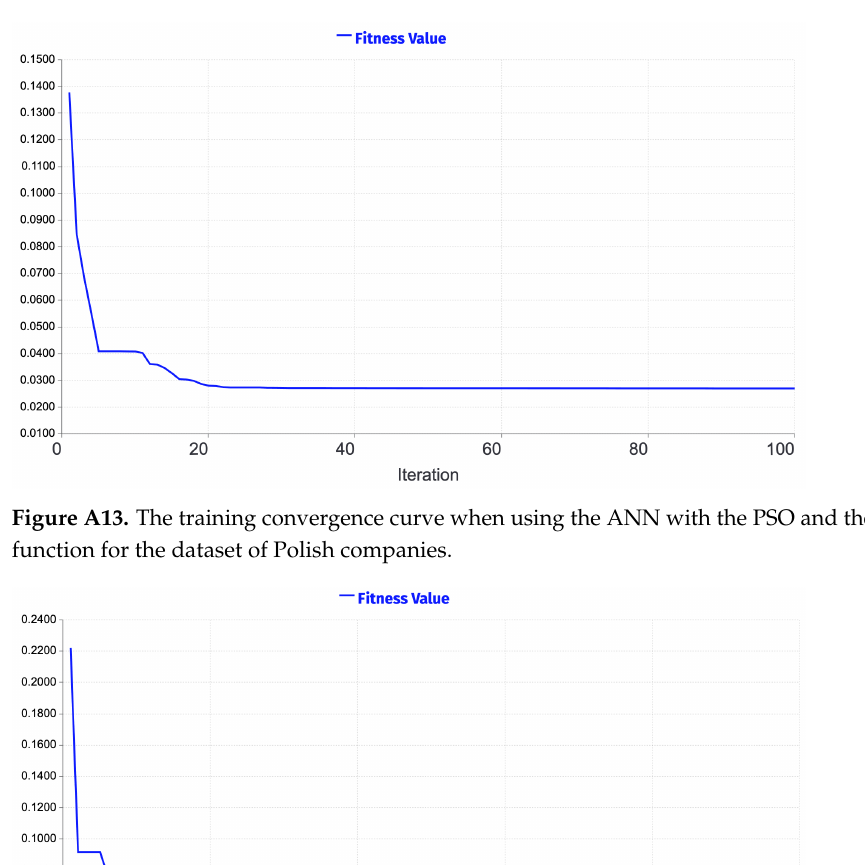
Figure A12. The training convergence curve when using the ANN with the CSO and the cost sensitivity fitness function for the dataset of Taiwanese companies.